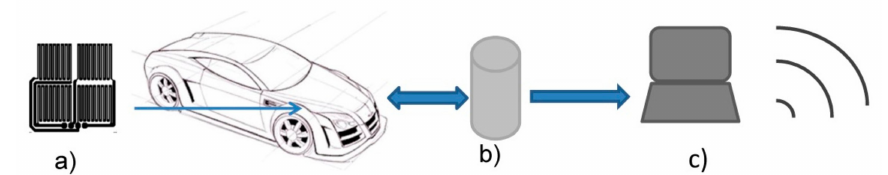
Figure 1. Schematic representation of the method of operation of a sensor for automotive corrosion measurements: ( a ) sensor unit, inserted in vehicle, ( b ) data logger, and ( c ) wireless data